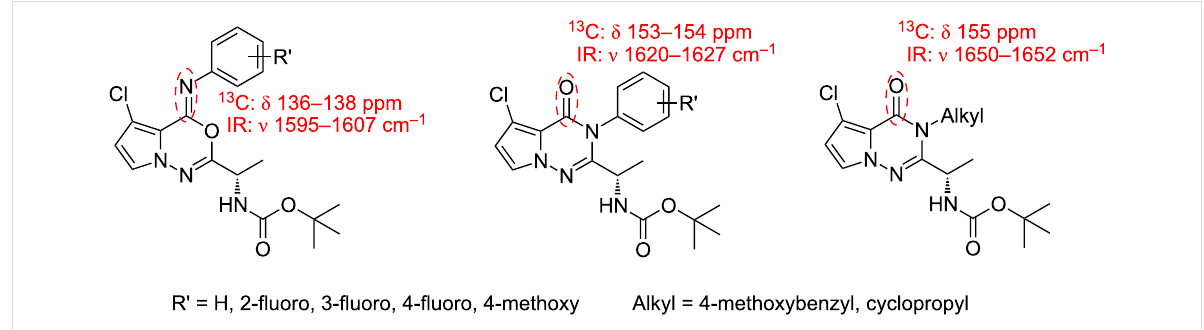
Figure 4: The results of 13 C NMR and IR studies.